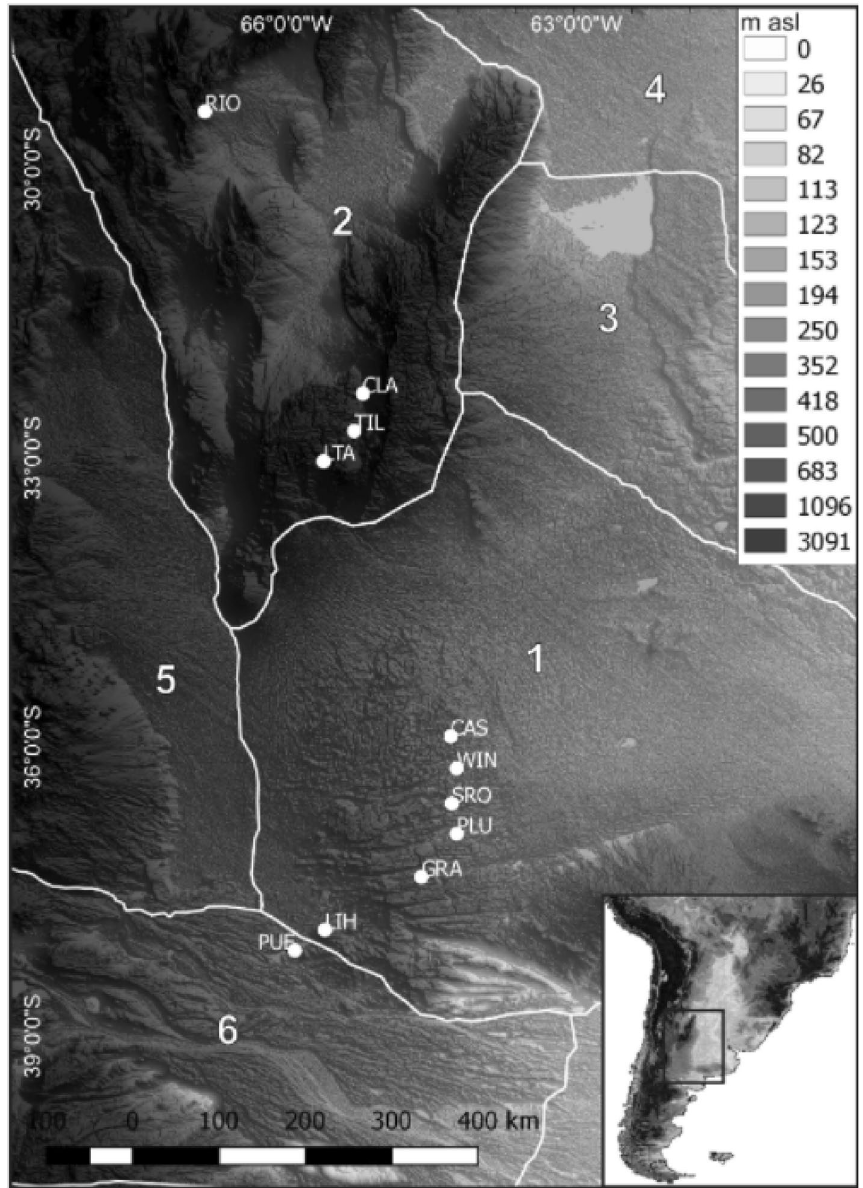
Figure 3. Distribution of the collected samples on a map of the natural quaternary regions of central Argentina taken from Iriondo22. The map is in a Global Multi resolution Terrain Elevation Data (GMTED201093) of 225 m resolution developed by the US Geological Survey (USGS) and the National Geospatial Intelligence Agency (NGA). https:// www. usgs. gov/ core- scien ce- syste ms/ eros/ coast al- chang es- and- impac ts/ gmted 2010? qt- scien ce_ suppo rt_ page_ relat ed_ con=0# qt- scien ce_ suppo rt_ page_ relat ed_ con. Google Earth Engine© cloud– based platform (GEE; https:// earth engine. google. com) and QGIS Geographic Information System (free open source software v.2.18; http:// www. qgis. org) were used for accessing and processing the open-source GMTED. Quaternary regions:1. South Pampa. 2. Inter-mountain valleys of the Pampean Ranges. 3. North Pampa. 4. Chaco. 5. Central Andes and the Eastern Piedmont. 6. Patagonia Plateau